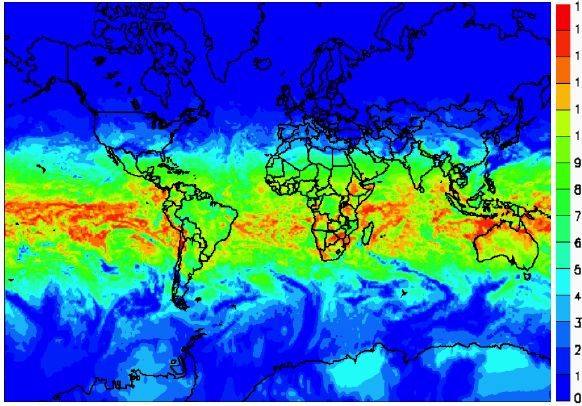
Figure 21. Global map of the NRT cloud-corrected UV index on 2 November